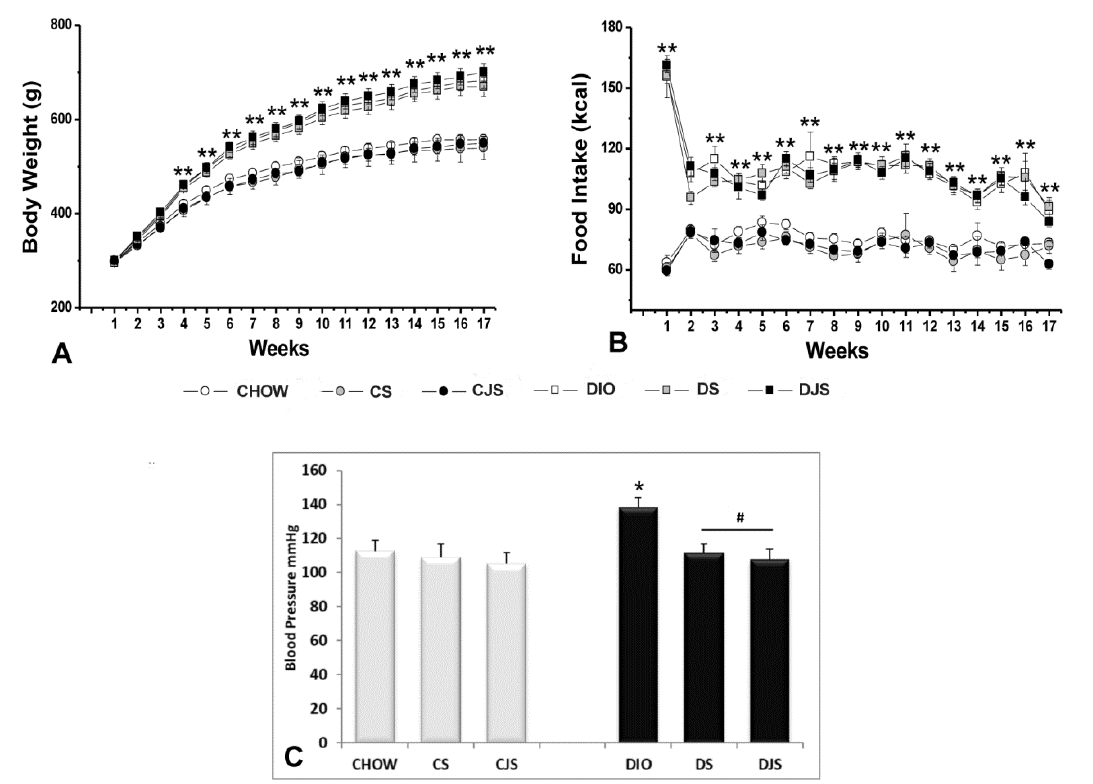
Figure 1. ( A ) Body weight in grams (g). ( B ) Food intake in kilocalories (kcal), measured weekly in